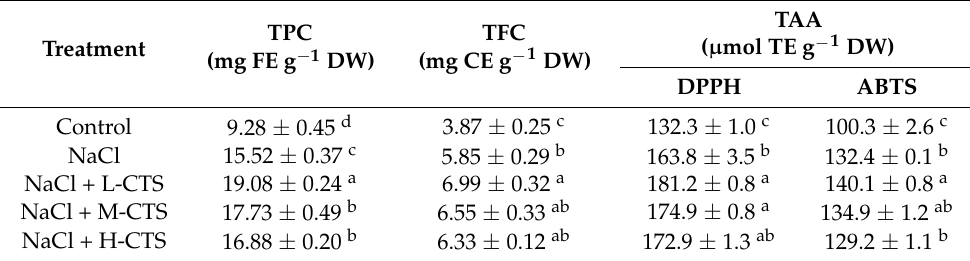
Table 2. Total phenolic content (TPC), total flavonoid content (TFC) and total antioxidant activity (TAA) in the shoot of durum wheat seedlings grown under control, NaCl stress and NaCl stress + CTS treatment.